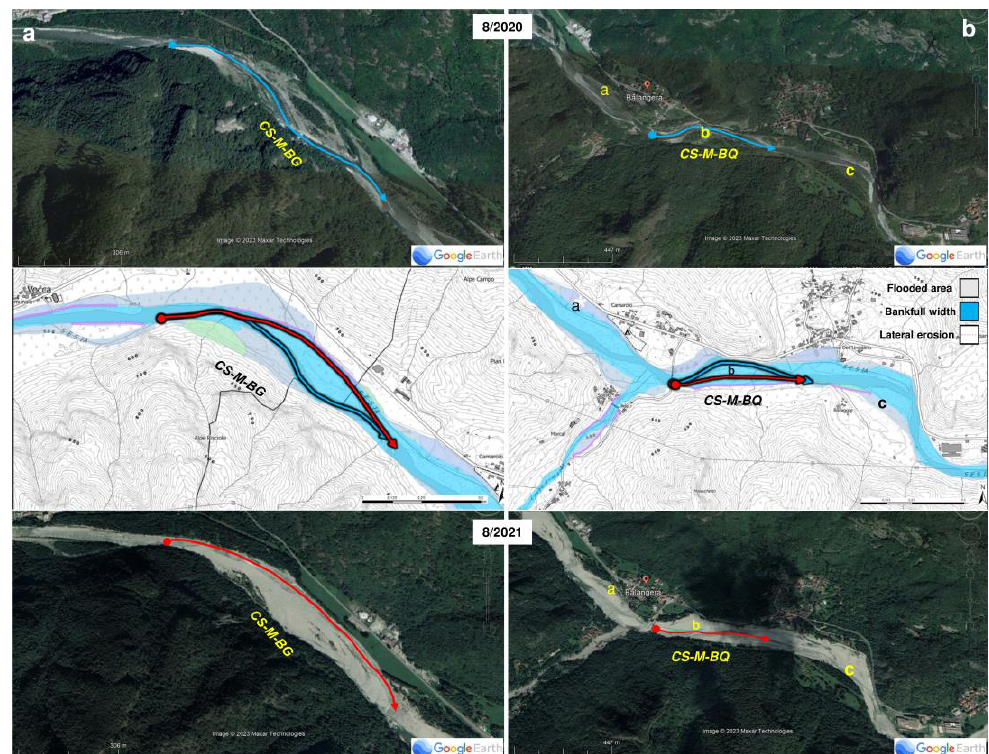
Figure 11. Examples of changes occurred along the Classico del Sesia . On the left (figures in column a ), the CS-M-BG reach, and, on the right (figures in column b ), the CS-M-BQ reach, along which the main channel migrated, inducing changes in rafting direction. The topographic maps are reporting the effect of the 2020 events, as mapped by Arpa Piemonte © (See Table 2). The satellite images are from Google Earth © before and after the 2020 event. Note that the 2021 satellite image (after event) was taken under a low hydrometric level; hence, the water flow is emphasized using arrows. a,b,c are the reference points among images. See location in Figure 8. For abbreviations, please see Section 3.1.